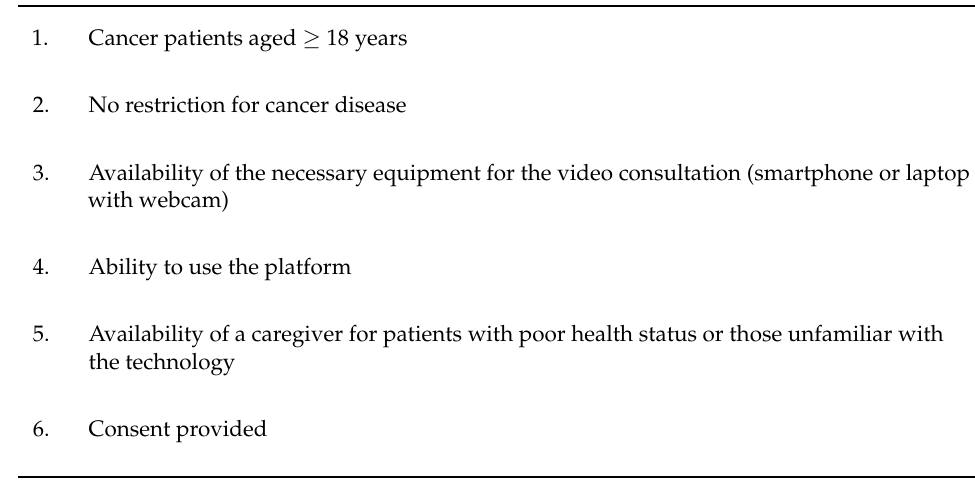
Table 1. Inclusion criteria for remote pain